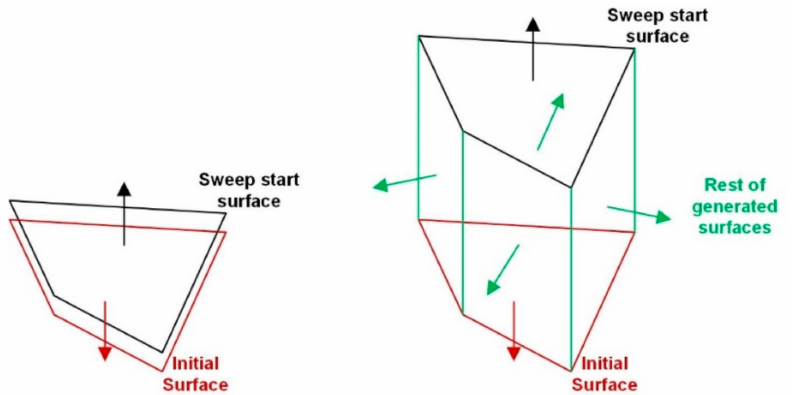
Figure 3. Solid generated by extrusion of a surface.